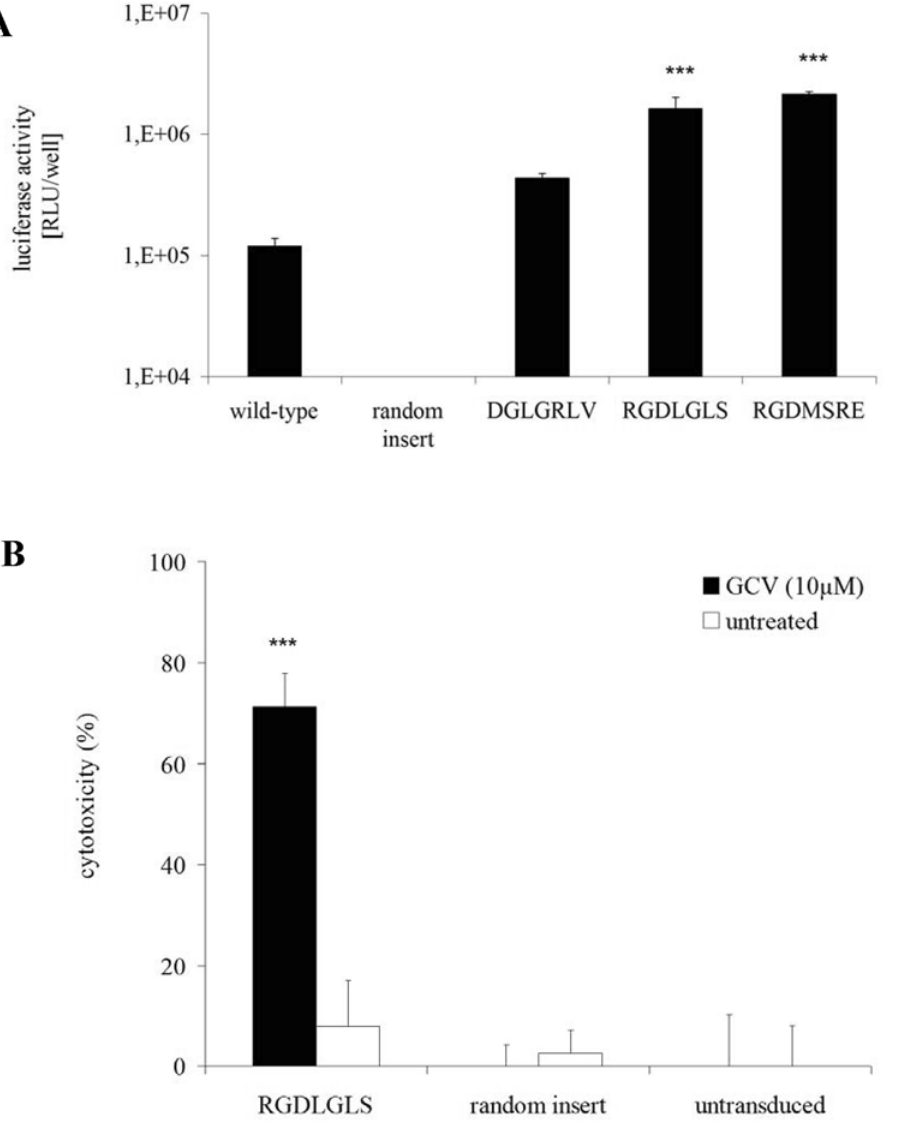
Figure 2. Vector capsids selected from random AAV display peptide libraries for targeted gene transfer in primary breast cancer cells. A: Primary PymT breast cancer cells were transduced by recombinant AAV-2 luciferase reporter gene vectors displaying the selected capsid peptide inserts RGDLGLS, RGDMSRE, or DGLGRLV, respectively. Capsids with no (wild-type) or random peptide insert (VRRPRFW) were used as controls. Transduction efficiency was determined after 72 hours by luciferase assay. Luciferase activities are shown in relative light units (RLU) per well. Data represent mean values 6 standard deviation (SD) from one representative experiment (out of three) in triplicates (***=p , 0.001 compared to wild-type and random insert controls). B: Breast cancer cell-targeted therapeutic suicide gene transfer using selected capsid mutants. Primary PymT cells were transduced using rAAV-SR39 vectors displaying RGDLGLS or a randomly selected control peptide (VRRPRFW). Four days after initiation of ganciclovir (GCV) treatment, cytotoxic effects were evaluated by MTT assay. Values are shown in % cytotoxicity (i.e., % killed cells). Untreated and untransduced cells served as controls. Data represent mean values 6 standard error of the mean (SEM) from nine wells in three independent experiments (***=p , 0.001 selected clone and treated cells vs. all